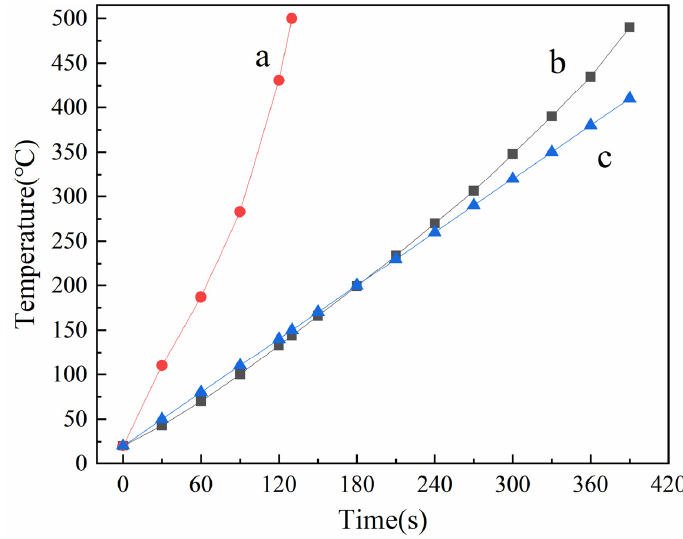
Figure 6. ( a ): Heating curve of MAM by microwave heating (800 W); ( b ): Heating curve of PbSO 4 (20 g) by microwave heating (800 W); ( c ): Heating curve of MAM by conventional heating (2700 W).